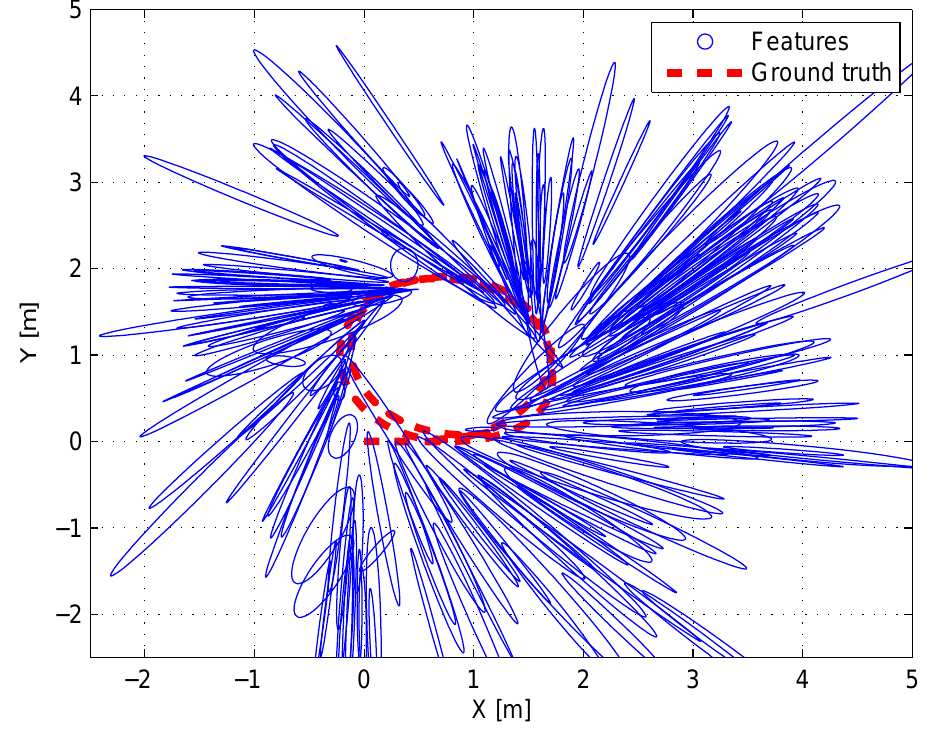
Figure 8. The top view of the indoor environment. Blue circles denote the covariance of features and the red dots denote the ground truth of the robot’s